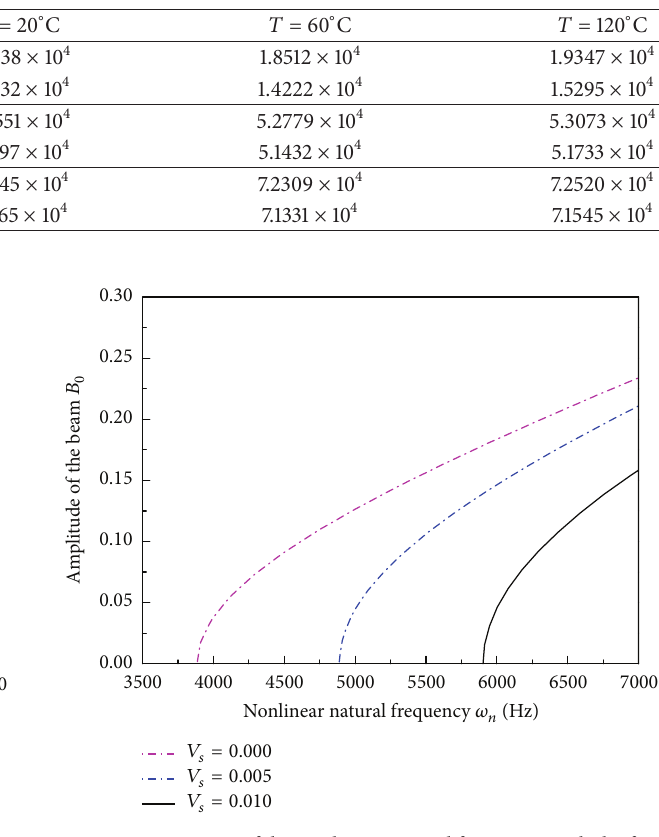
fibers appears to have marginal effect on the nonlinear natural